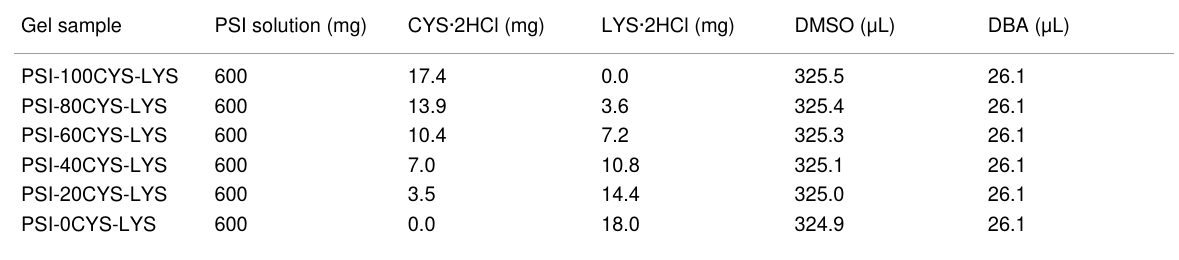
Table 1: The applied amounts of the various components during the gel synthesis. Gel